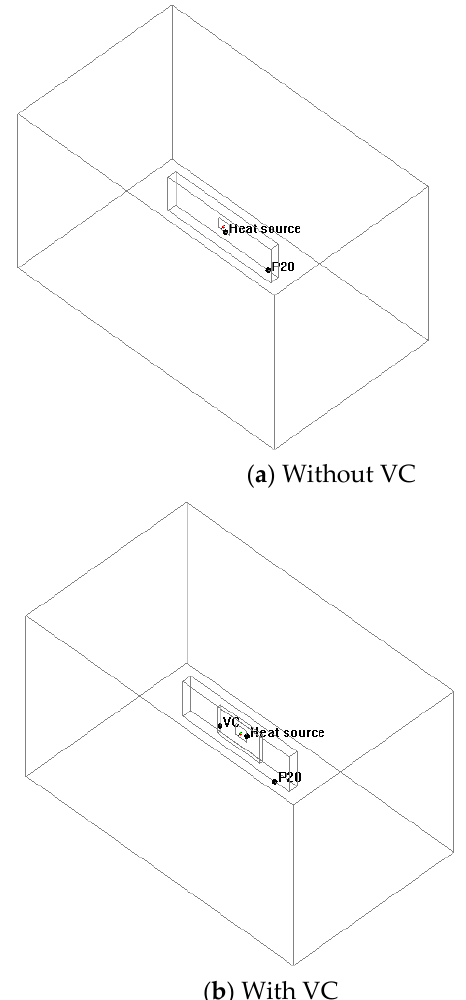
Figure 5. CFD simulation models.